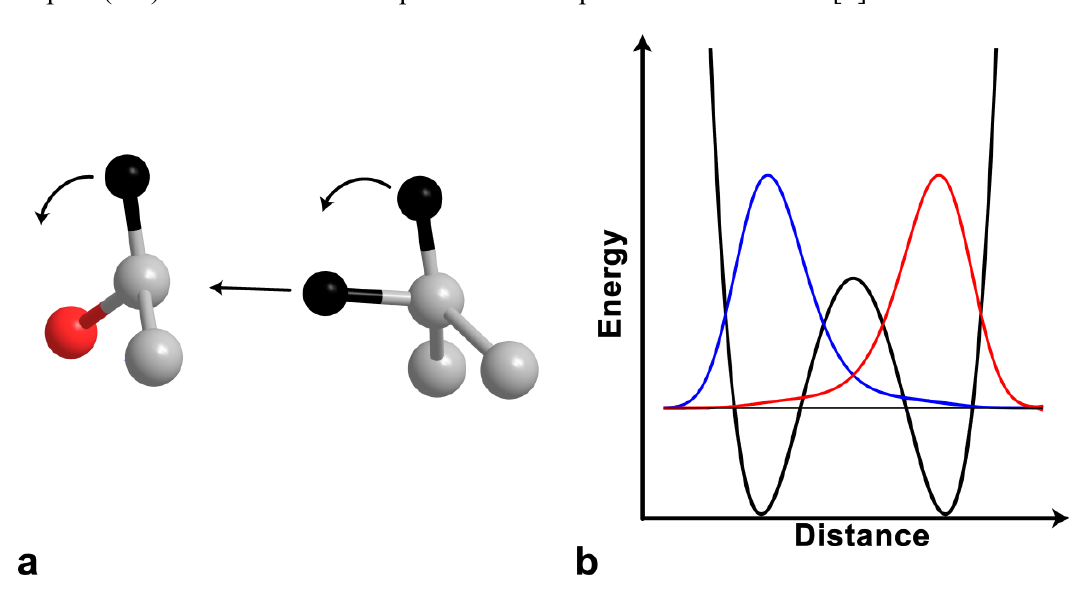
Figure 2. The model of tunneling and coupled motion. ( a ) The reaction coordinate involves motion of both the 1° and 2° atoms, which tunnel through the reaction barrier. ( b ) The efficiency of tunneling is proportional to the overlap between donor (blue) and acceptor (red) wave functions. Reproduced with permission from ref.